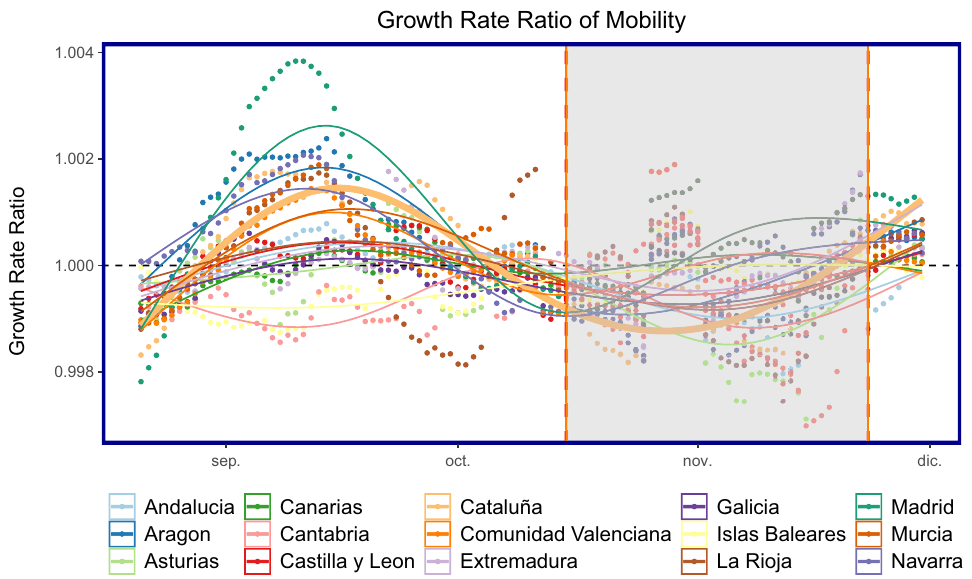
Figure 9. Growth rate ratio (GR) of mobility: all autonomous communities are shown as points with Cataluña shown as the thicker line plot for ease of composition. The shaded area corresponds to when the policy of closing bars and restaurants in Cataluña was implemented. On the x-axis, dic refers to Diciembre